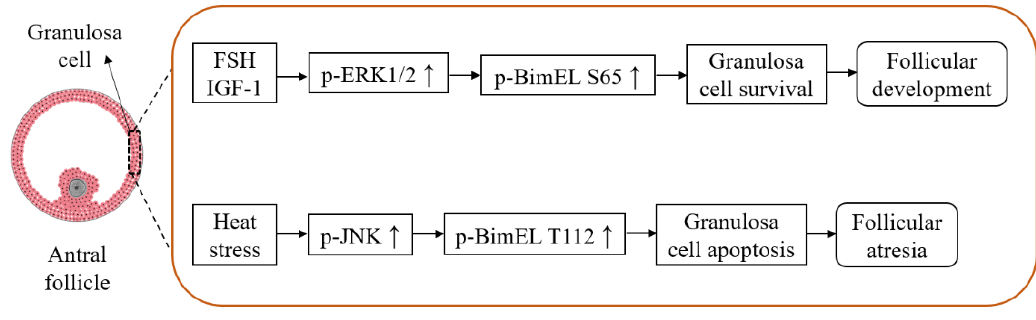
Figure 6. Hypothetical model of functions and regulations of p-BimEL S65 and p-BimEL T112 during follicular atresia.